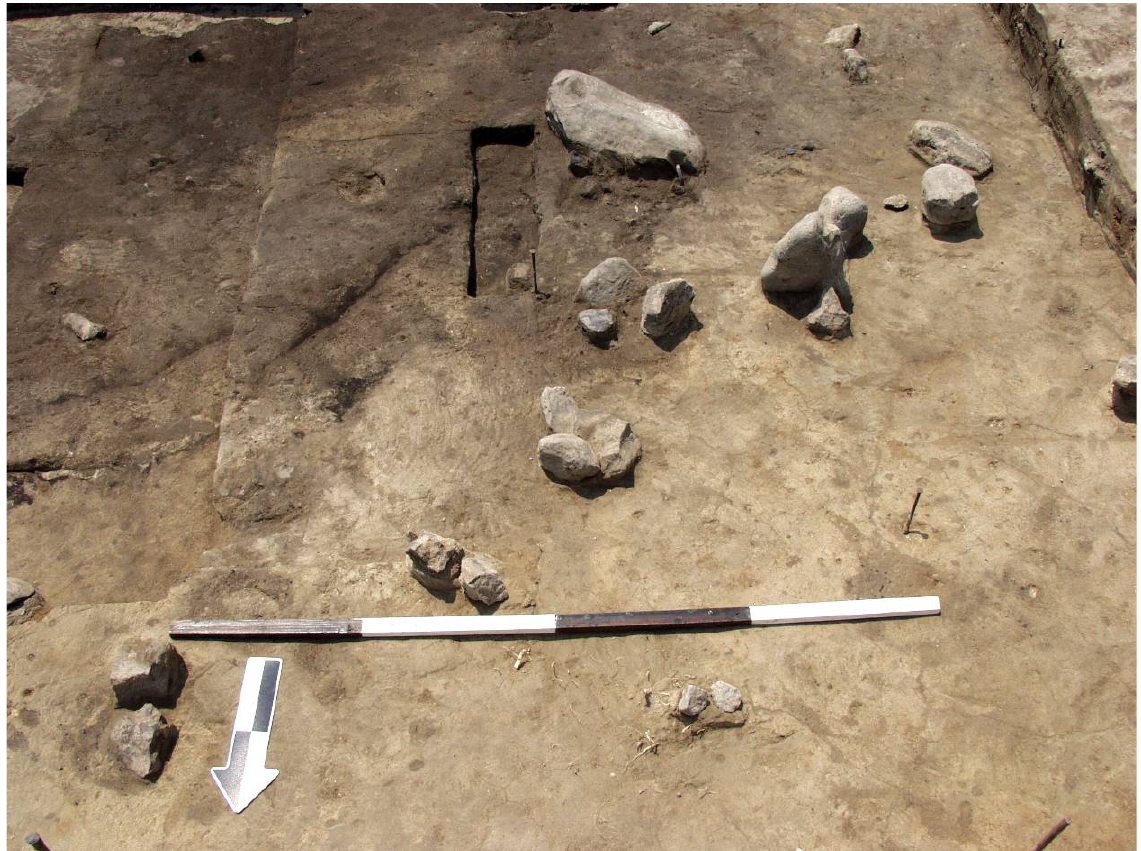
Figure 17. An arc of stone sets around the northwest wall of Brush Hut